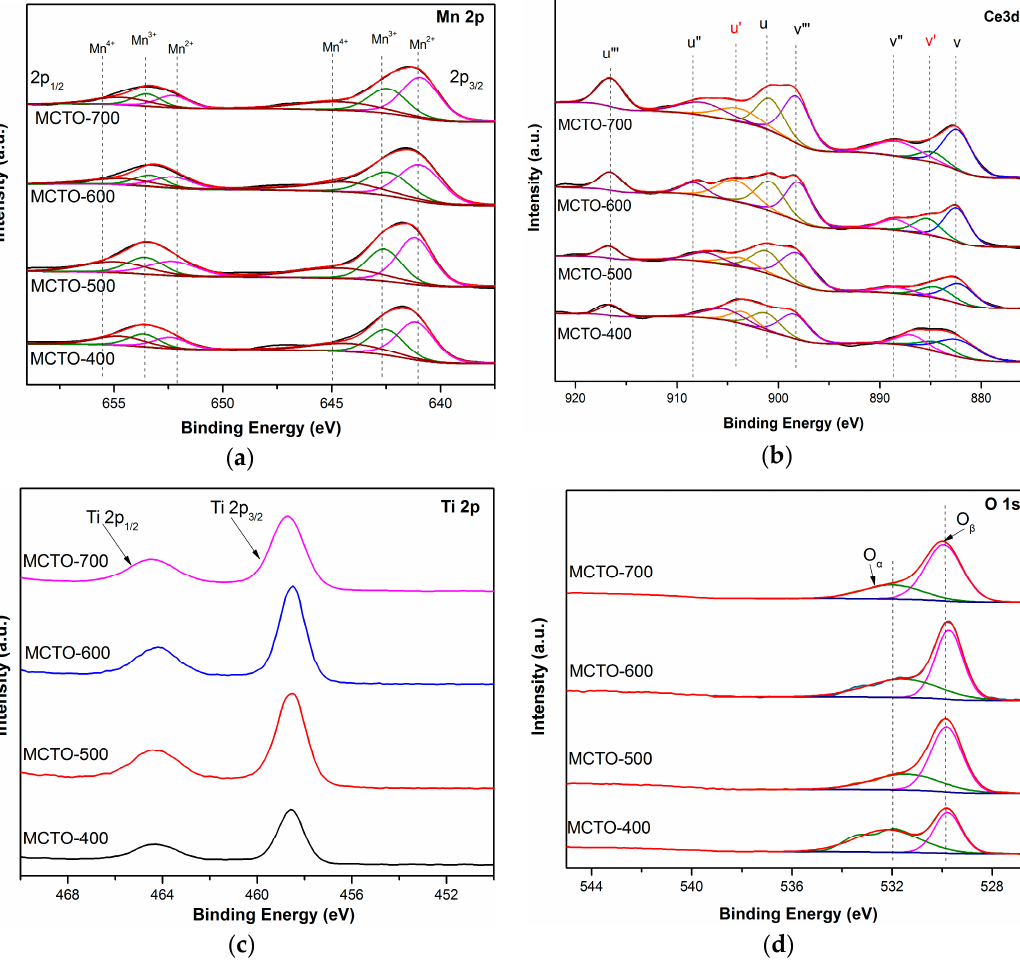
Table 3. Surface atomic compositions of catalysts measured by